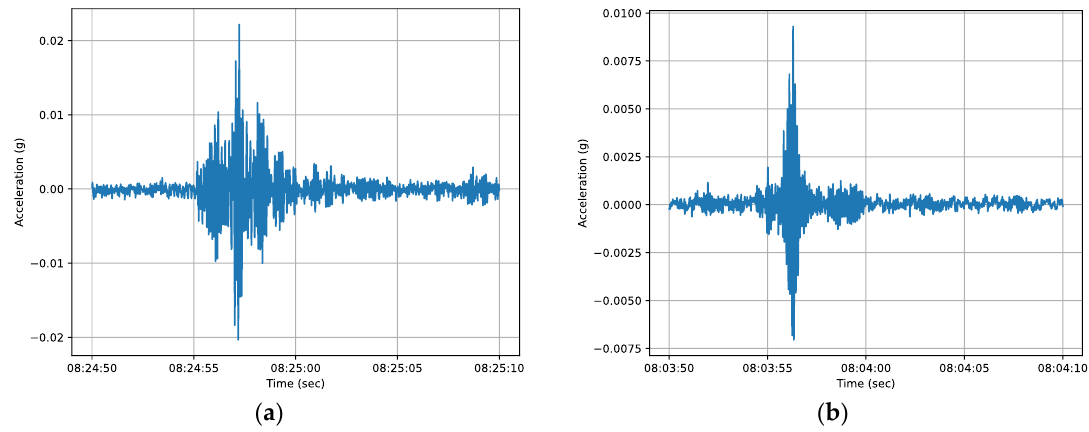
Figure 6. Data measured by accelerometers: ( a ) Seolmun Bridge; ( b ) Gajwa Bridge.